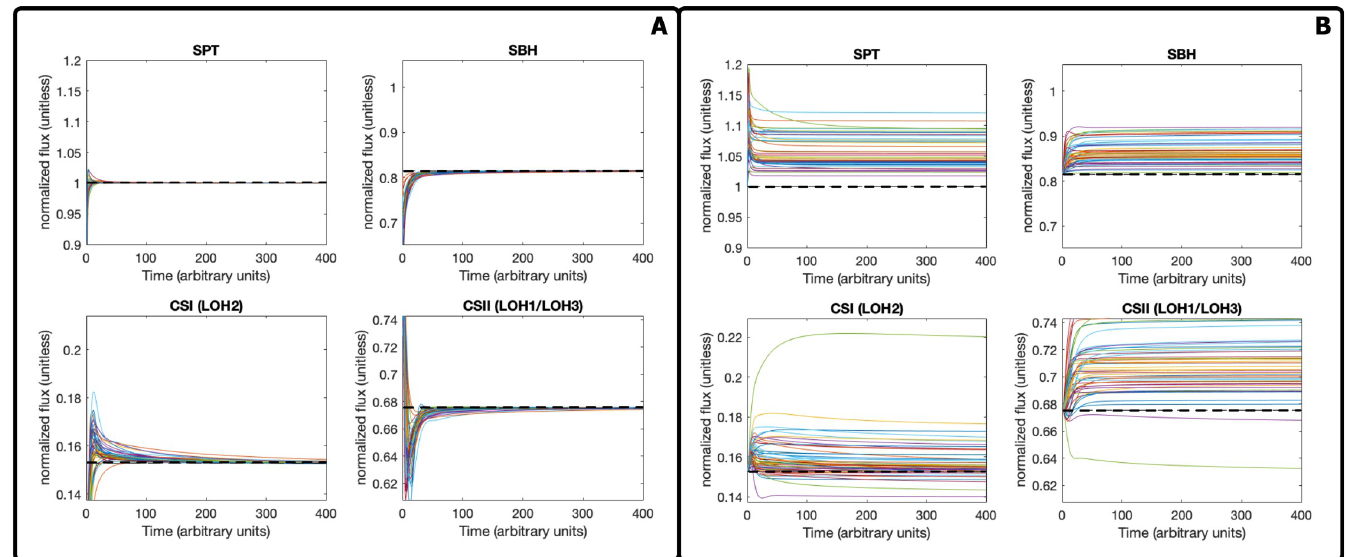
Fig 3. Model behavior under different conditions. (A) The flux profiles of different reactions during the reference (wild type) state. All of the models in the ensemble reach the same steady-state flux. The dashed line refers to the reference steady-state value. (B) The flux profiles of different reactions during a perturbed state. The displayed perturbation is an ORM repression. The dashed line refers to the reference steady-state value.